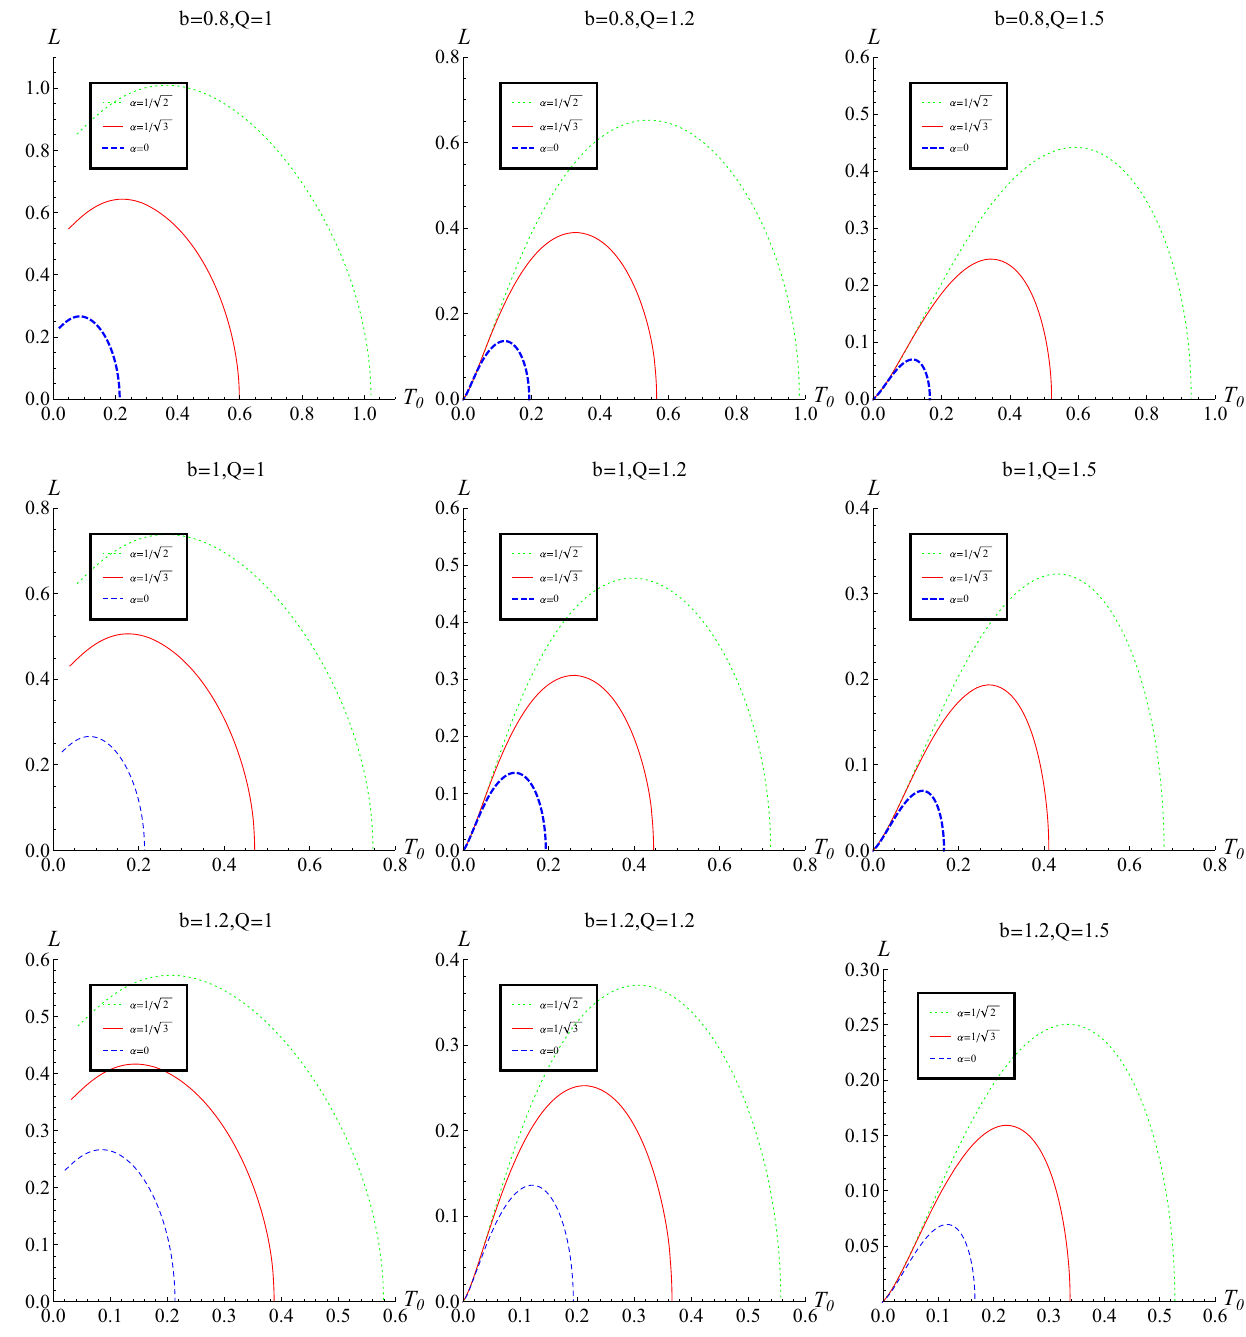
Fig. 5 L – T curves for the topological dilaton black hole in n - dimensional AdS spacetime as n = 5. In the diagram, we have the first line with b = 0 . 8, the second line with b = 1 . 0, the final line with